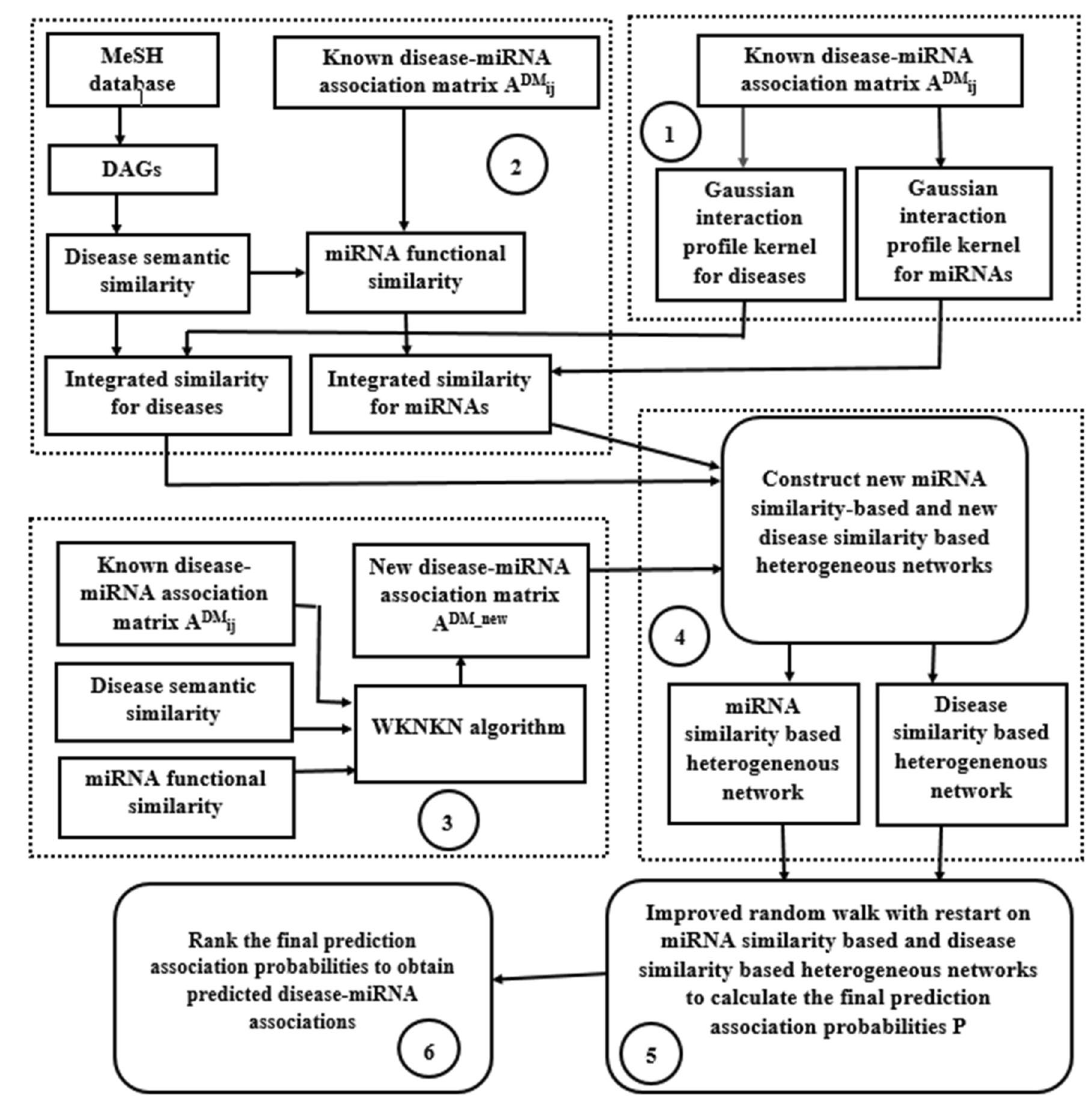
Figure 1. The workflow of the proposed method